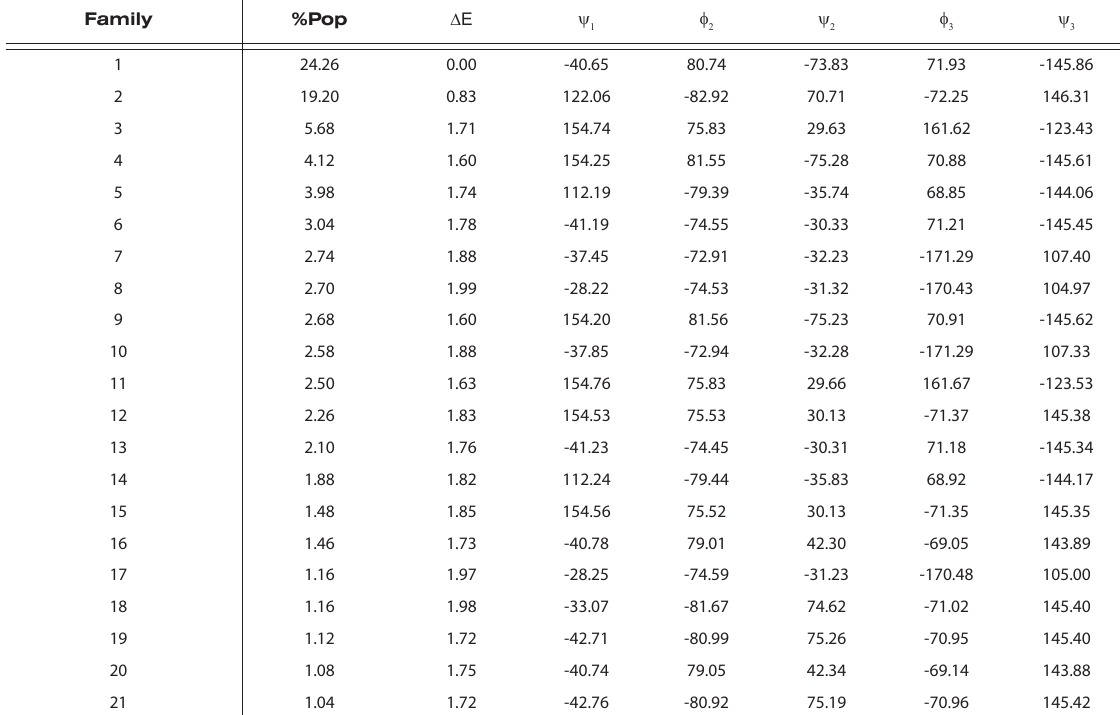
Table 3. Percent relative populations, relative energy values and torsional angles for the backbone conformers of YGG optimized at the EDMC/SRFOPT/ ECEPP/3 level of theory. All conformational families shown here have relative population (%Pop) higher than 1.0% and a relative energy (DE) lower than 2.0 kcal mol